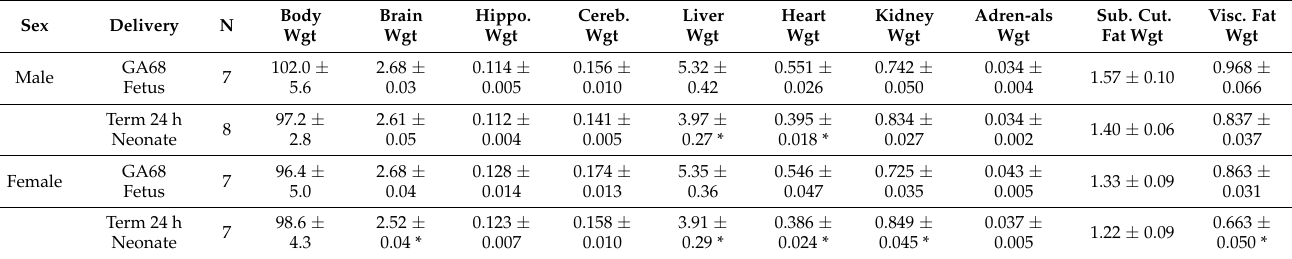
Table 2. Post-mortem body and absolute organ